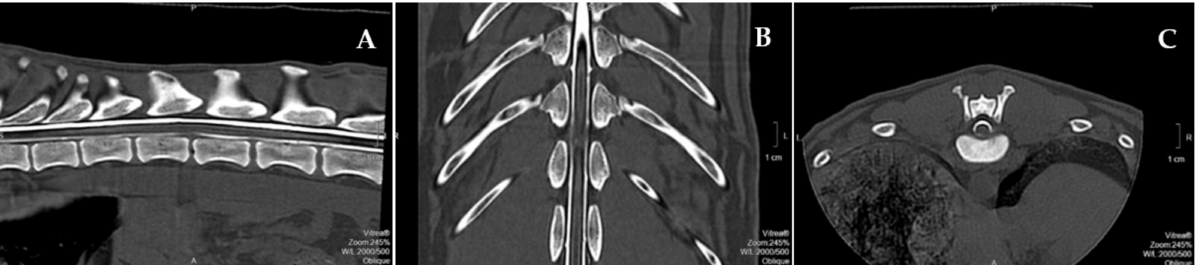
Figure 1. Computed Tomography–Myelogram image from a 6-year-old Labrador with T12–T13 acute non-compressive nucleus pulposus extrusion. ( A ) Vacuum phenomenon and light attenuation of the ventral contrast line diameter (sagittal view); ( B ) T12–T13 hyperintensity sign and bilateral light attenuation of the diameter of the contrast lines (dorsal view); ( C ) normal T12–T13 disk space with residual mineralized disk material ventrally (transverse